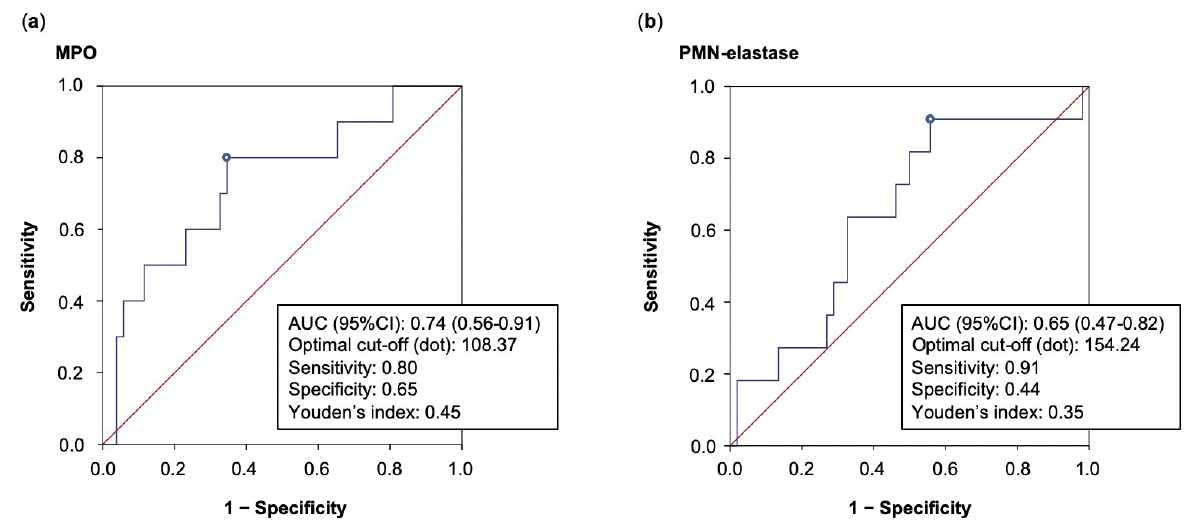
Figure 3. AUC and optimal cut-off values obtained from ROC curve analysis of biomarkers with best prognostic performance in terms of MACE and/or MALE, namely MPO ( a ) and PMN-elastase ( b ). AUC: area unde the curve; MPO: myeloperoxidase; PMN: polymorphonuclear neutrophil.